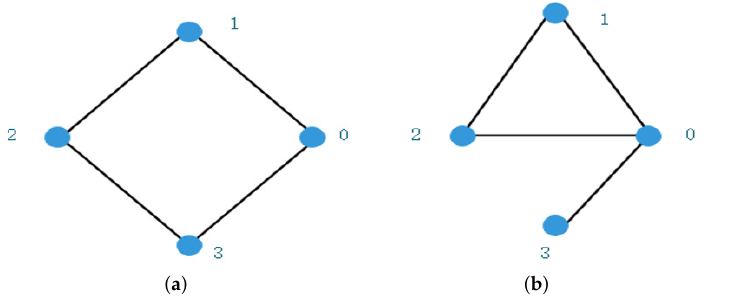
Figure 10. Two kinds of topology networks ( N = 4, p re = 0.5, ¯ k = 2 ) . ( a ) Ring topology; ( b ) Mesh